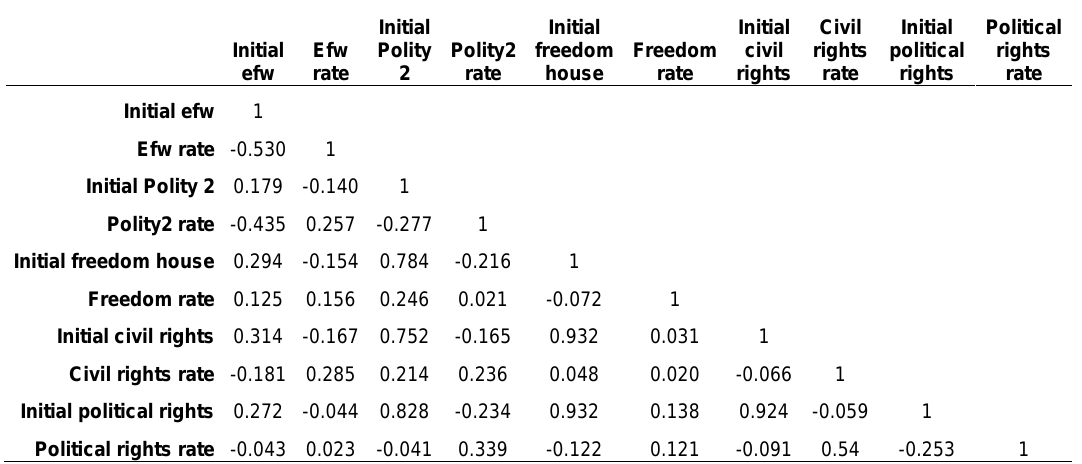
Table 4 . Correlation